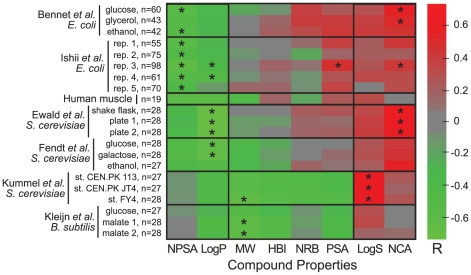
Correlation (R) between the logarithm of metabolites concentrations in each data set and the physico-chemical parameters of metabolites.Only metabolites with MW<300 were included in this analysis (see Text S1 and Figure S1). We computed the p-value of each R2 and determined its significance, as explained in the Methods. A correlation that was found to be significant (false discovery rate of 0.01, see Methods) is denoted by *. Parameters abbreviations are as in Figure 1.